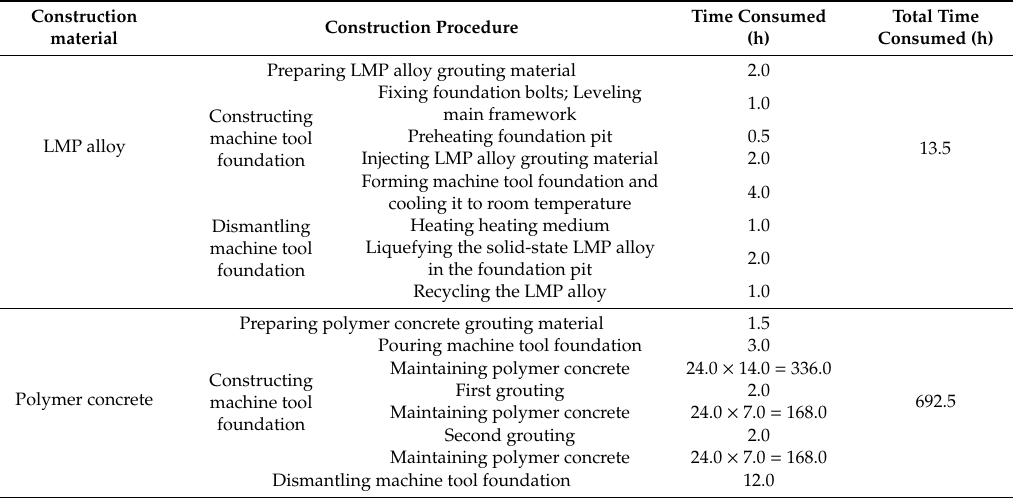
Table 5. Machine tool foundation construction